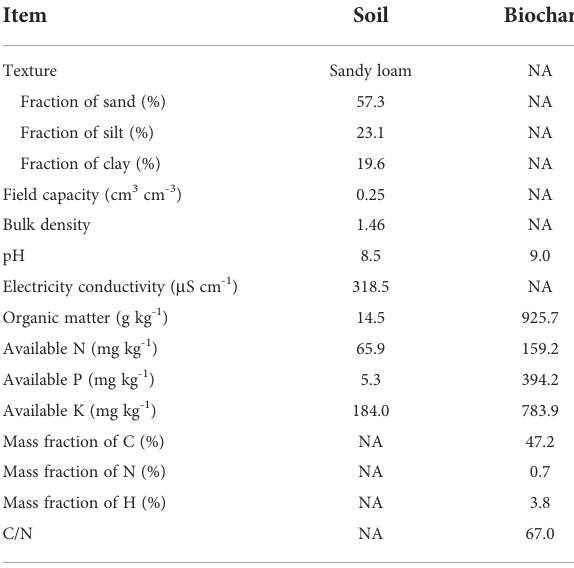
TABLE 2 Physical and chemical properties for sandy loam soil and maize residue biochar. Item Soil Biochar